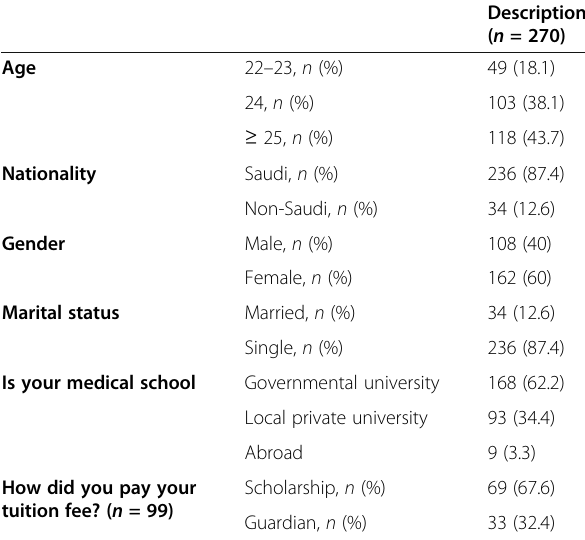
Table 1 Description of the demographic data